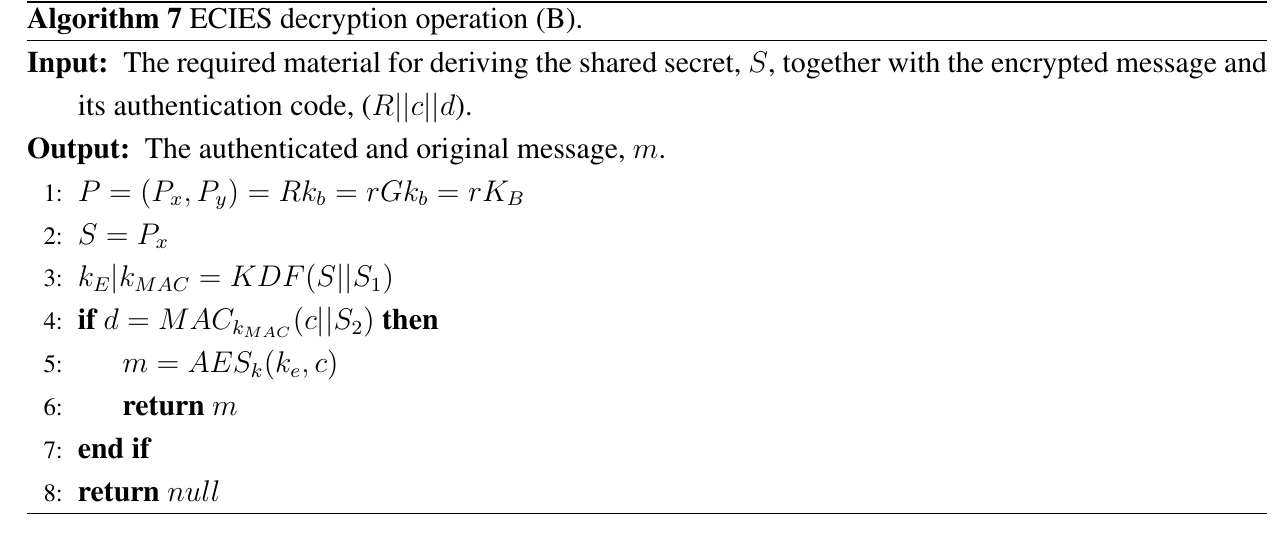
Algorithm 7 ECIES decryption operation (B).